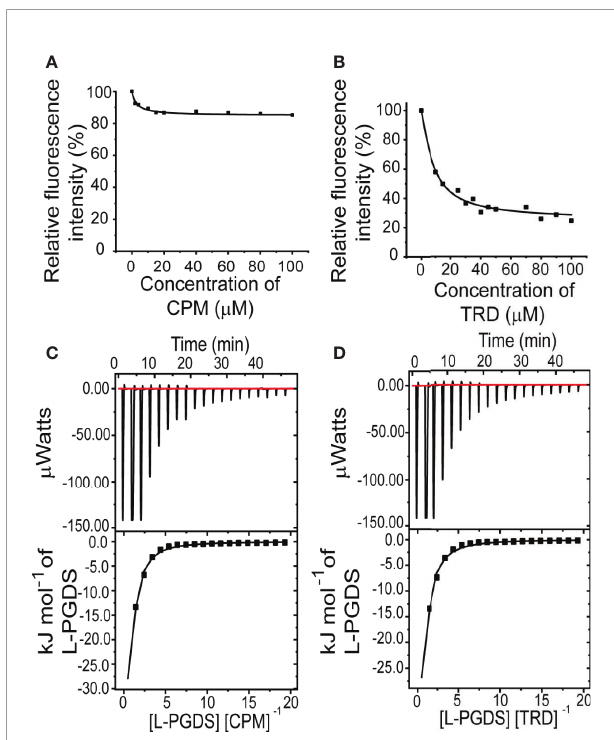
FIGURE 1 | Interactions between L-PGDS and the two drugs — CPM and TRD. Tryptophan fl uorescence quenching of L-PGDS monitored at 340 nm is plotted against the various concentrations of CPM (A) , TRD (B) . About 2 µM of L-PGDS in 50 mM sodium phosphate buffer pH 7.0 was used. Thermodynamic analysis of L-PGDS binding to CPM (C) and TRD (D) in 50 mM sodium phosphate buffer pH 7.0 by ITC. L-PGDS was reversely titrated to 2 µM of CPM and 2 µM of TRD. The top panes show thermograms and binding isotherms. The bottom panels show the change in heat obtained.